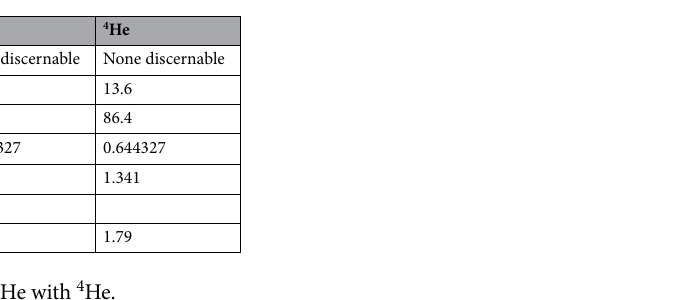
Figure 3. Scalar charge density of